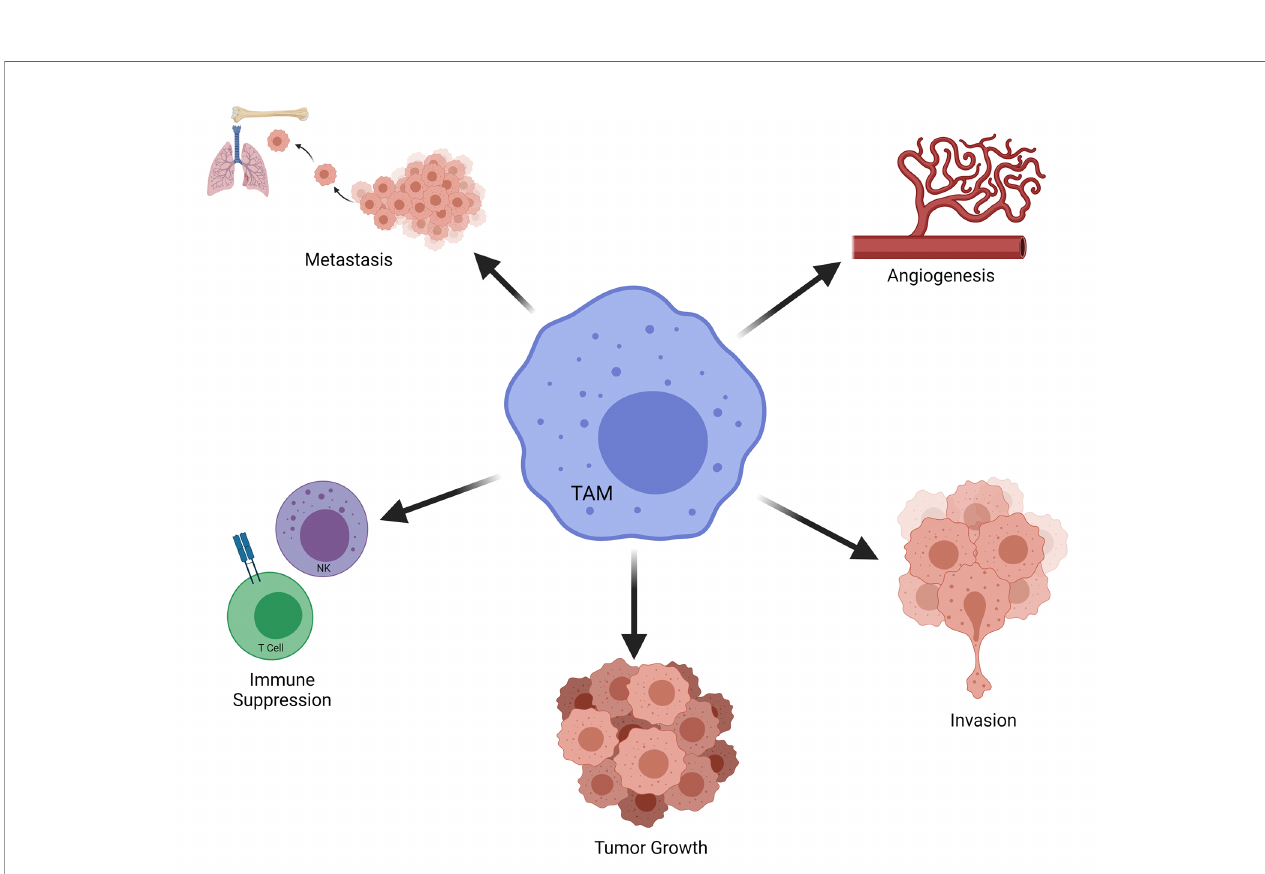
FIGURE 8 | Role of TAMs on Tumor Progression. Selected effects of TAMs in tumorigenesis are demonstrated. NK, natural killer; TAM, tumor associated macrophage.